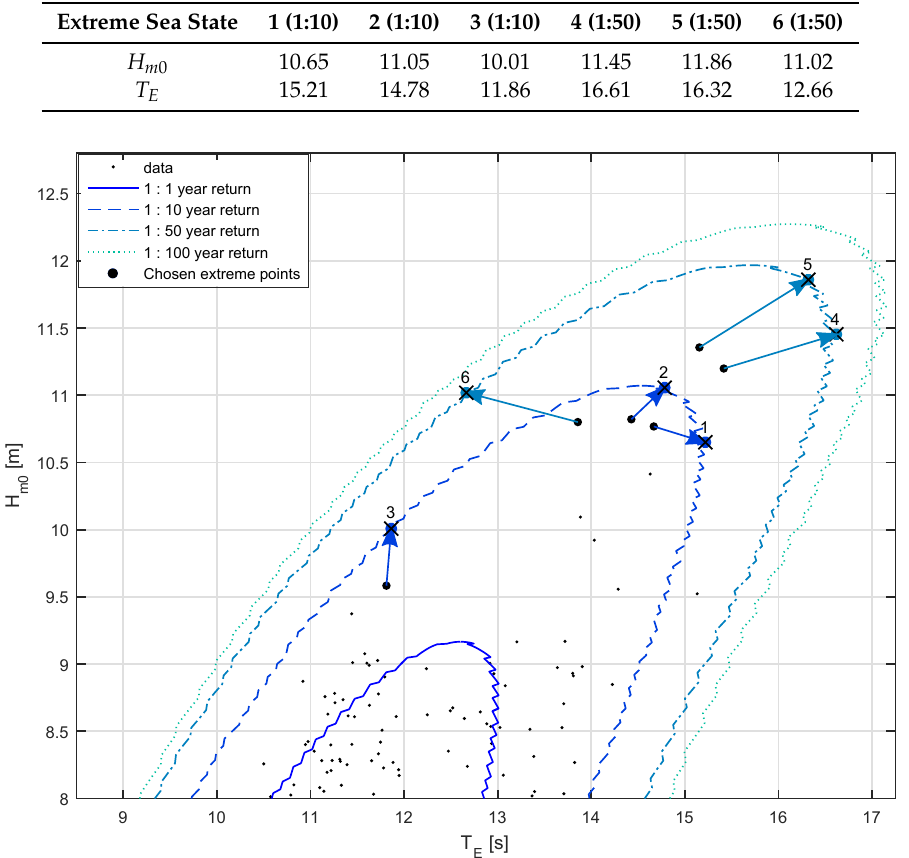
Table 1. Example extreme H m 0 – T E combinations for 1:10 and 1:50 year conditions.